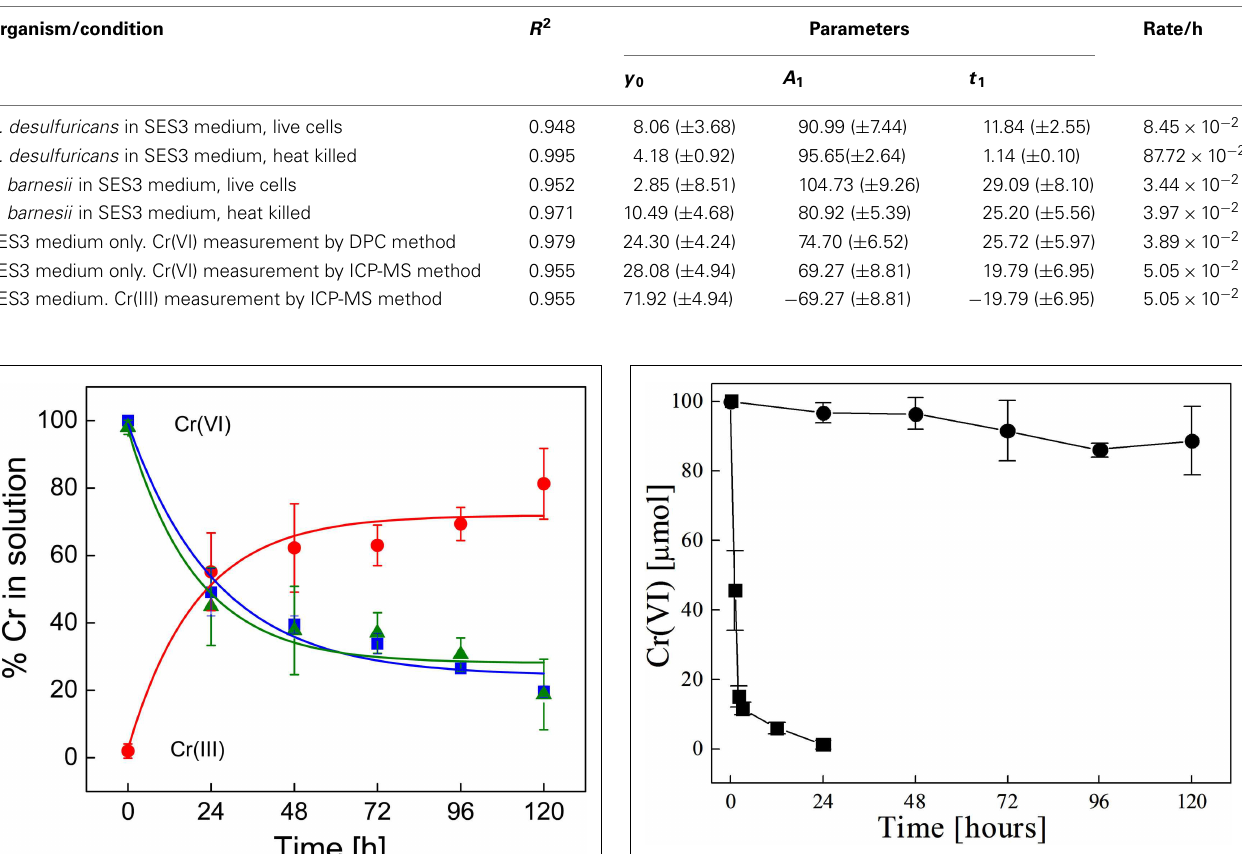
FIGURE 2 | Chromium(VI) reduction in uninoculated SES3 medium as determined by the diphenylcarbazide method ( (cid:4) ) for Cr(VI) and by the isotope dilution method with ICP-MS for Cr(VI) ( (cid:78) ) and Cr(III) ( of the measurements was done in triplicate with standard.The spline curves represent non-linear curve fitting.